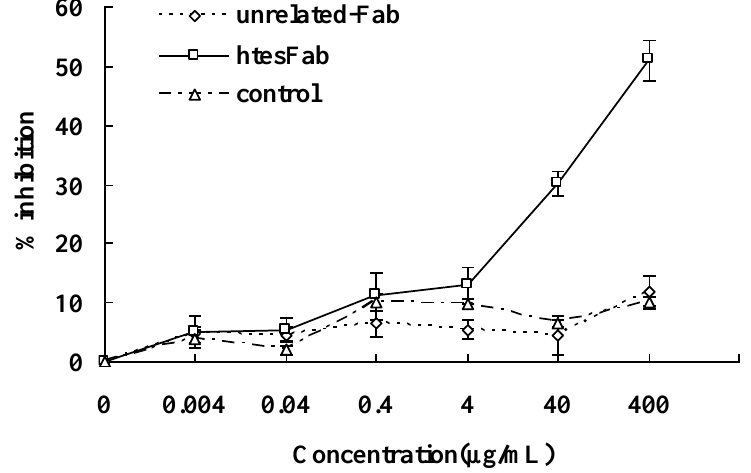
Figure 4. htesFab inhibits the proliferation of HNE2-LMP1 cells in vitro . The cells were treated as indicated and harvested 48 h later. The proliferation of cells was assessed by MTT assay to calculate the proliferation inhibition rate